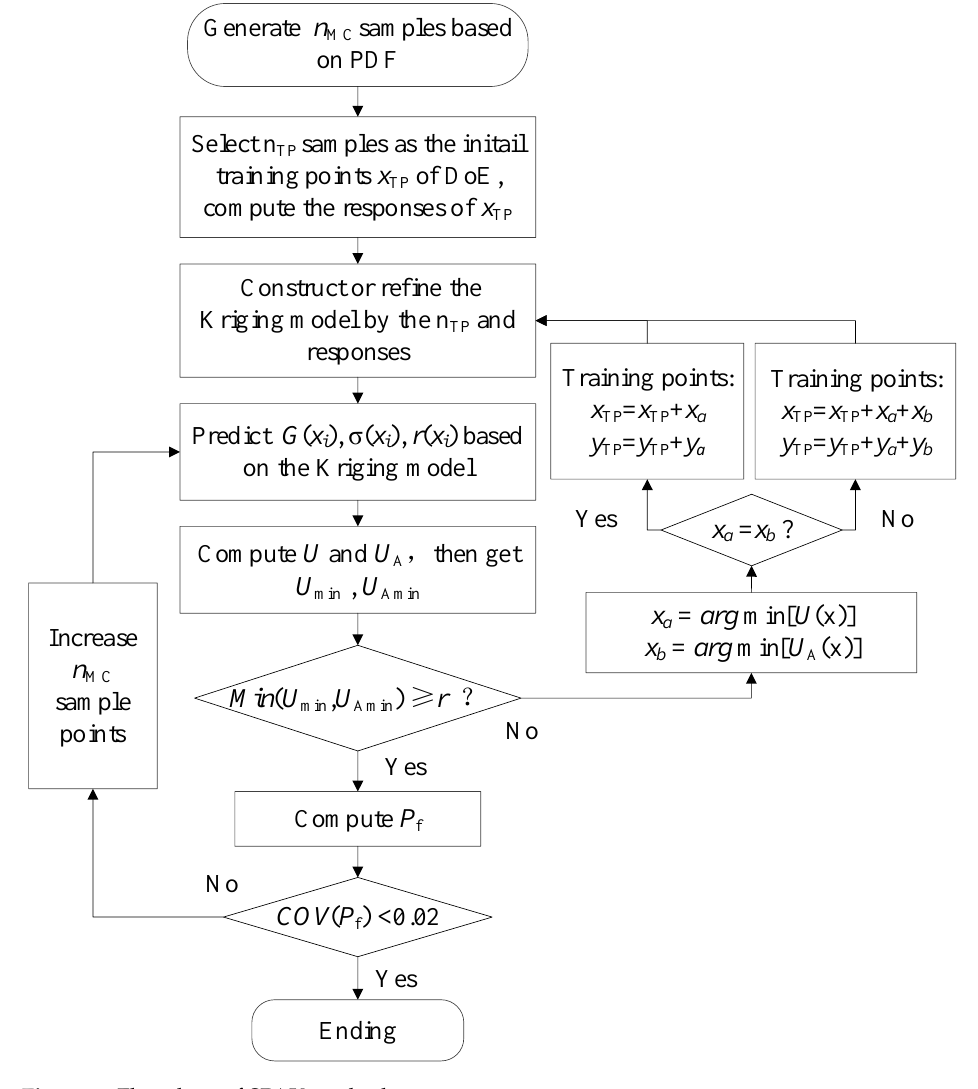
Figure 1. Flowchart of SPAK